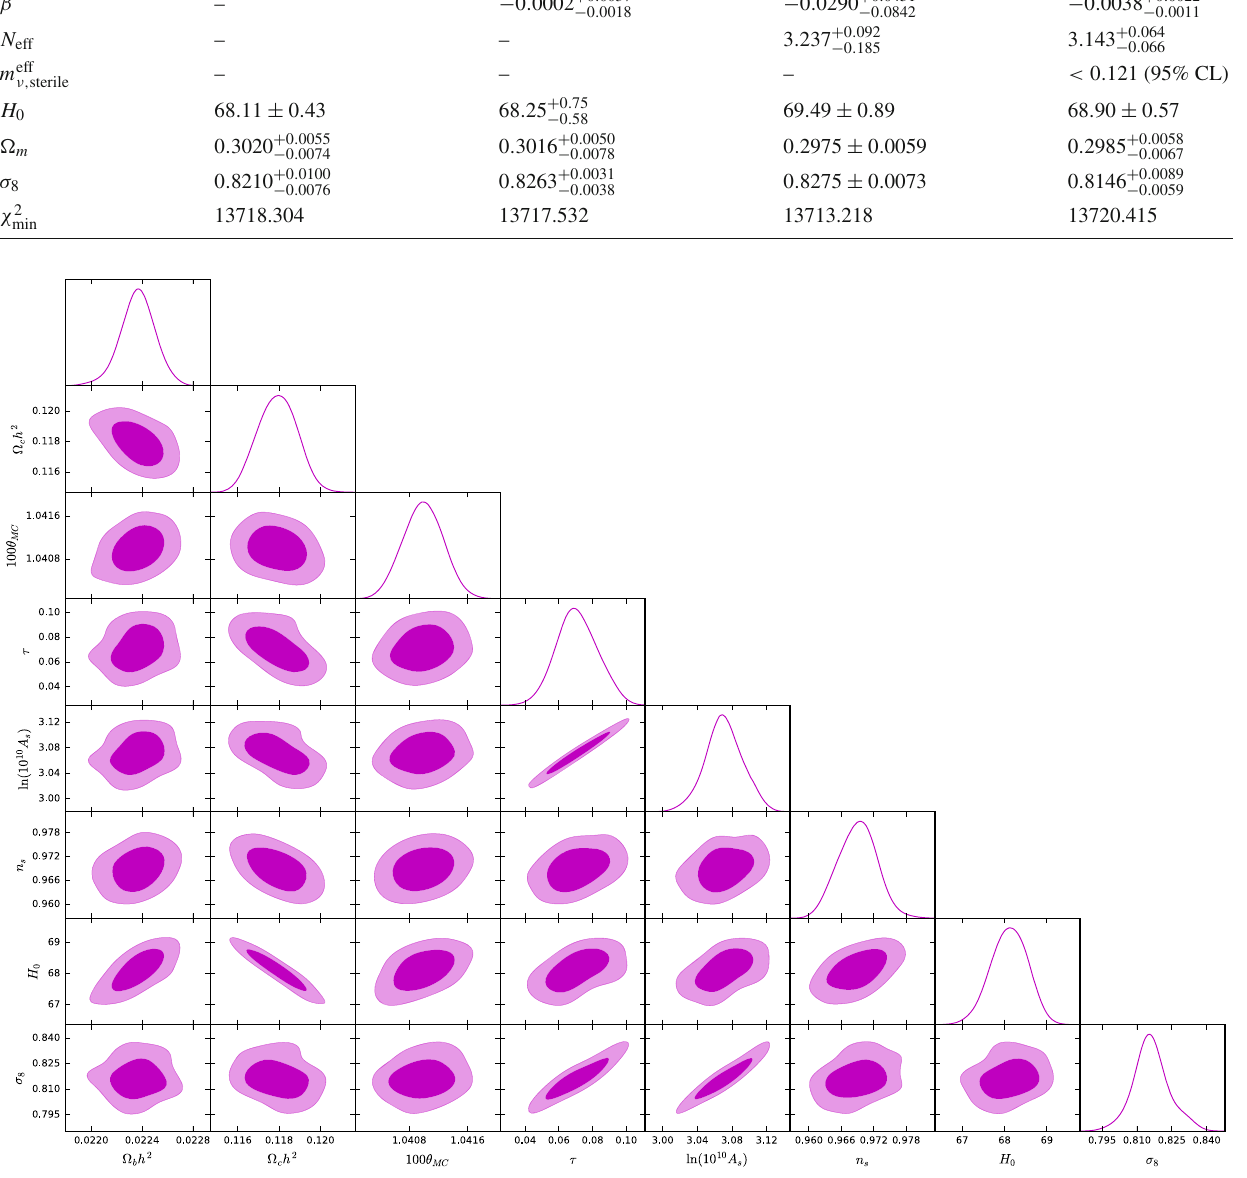
Fig. 1 The 1-dimensional marginalized distributions and 2-dimensional contours for the parameters of the (cid:5) CDM model by using the data combination